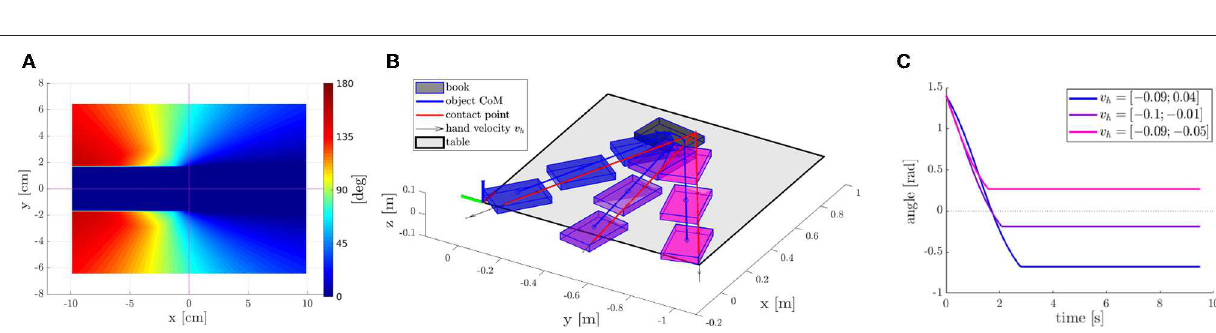
FIGURE 6 | Strategy 2 Pivot and Re-Grasp–predicted rotation obtained for each contact point when E ν H = [1,0] adding the conditions under which, due to torsional friction, the angular velocity ω = 0. (A) Example motions of a rectangular object on a table. (B) Trajectories for different velocities. (C) Rotation of the object.